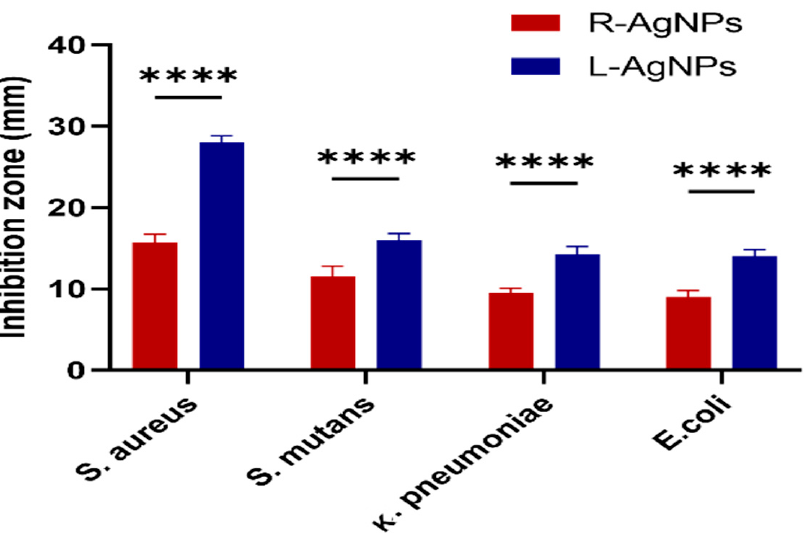
Figure 16. Antibacterial activity of L-AgNPs and R-AgNPs as inhibition zones (mm) against four different bacteria. Two-way ANOVA with multiple comparison was performed to identify differences between groups. p < 0.0001 (****).